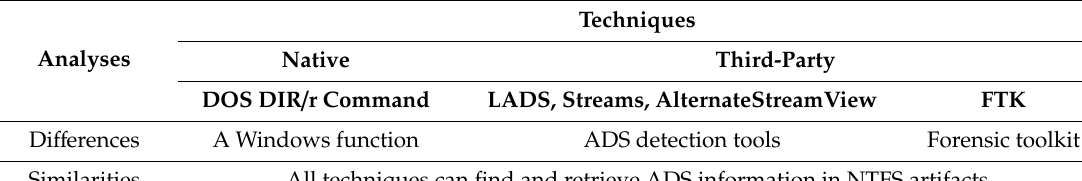
Table 3. Comparative analyses in detecting ADS